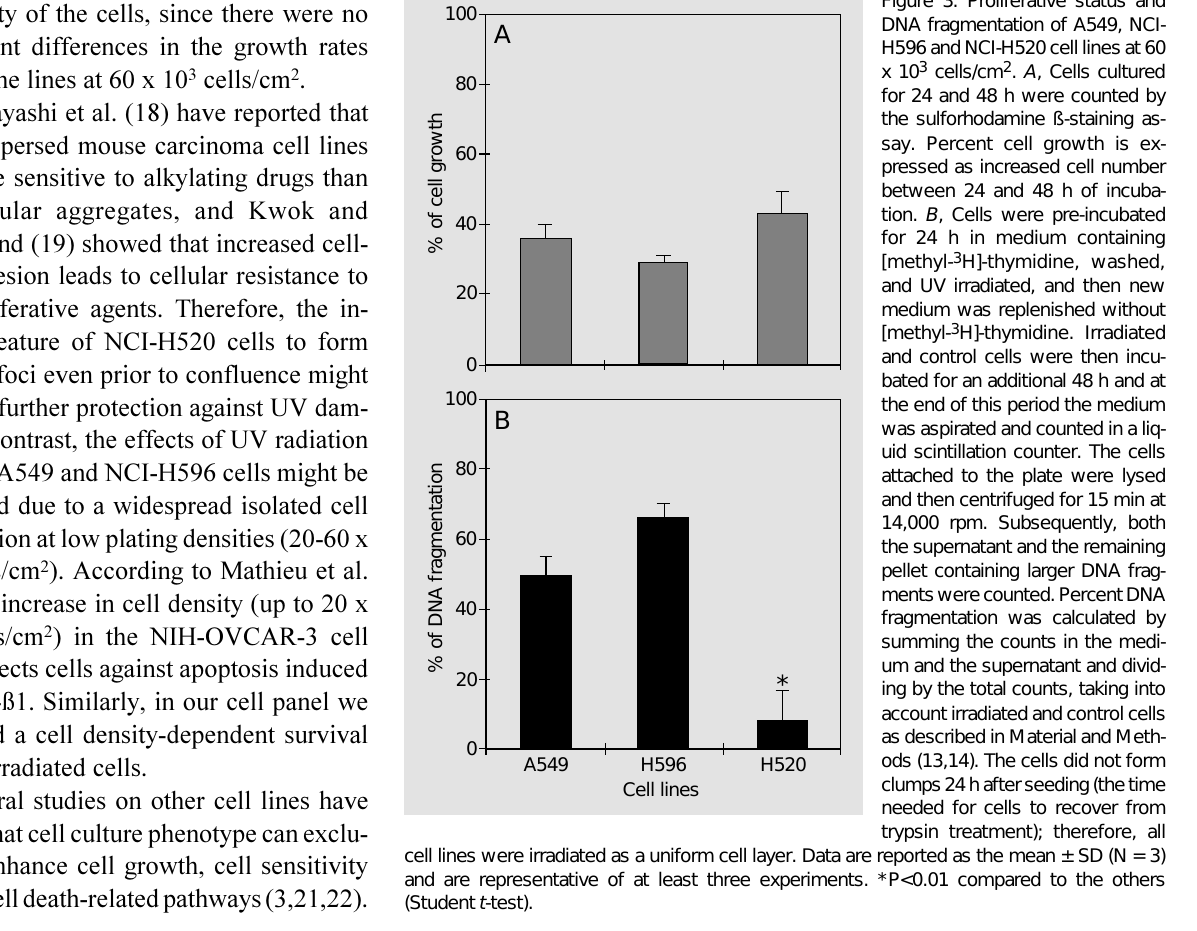
Figure 2. Growth inhibition of A549, NCI-H596 and NCI-H520 cell lines UV irradiated at different plat- ing densities. Cells were pre-incu- bated for 24 h, exposed to UV, and then incubated for an additional 48 h and counted. Cell number was determined by the sulforhodamine ß-staining assay. The number of irradiated cells (T) after the final 72 h was then compared to the num- ber of non-irradiated cells (C) incu- bated simultaneously for the same 72-h period. Growth inhibition (GI) was determined by the formula GI = (1 - T/C) x 100 (i.e., a T/C value of 0.3 means that cell culture grew only 30% of the control, giving a GI = 70%; alternatively, potential